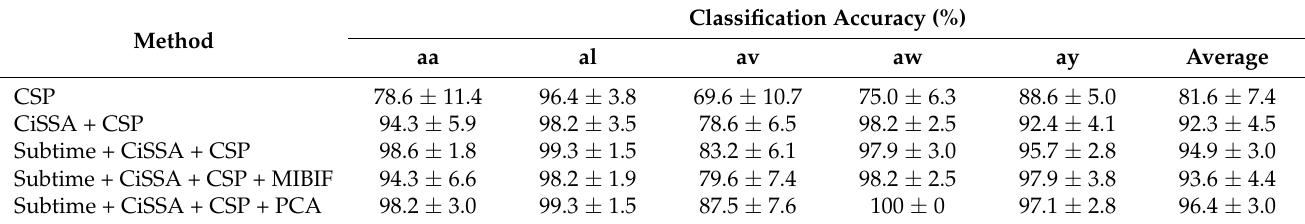
Table 1. The classification accuracies of the proposed CiSSA-CSP method on BCI Competition III dataset IVa (subject aa, al, av, aw, and